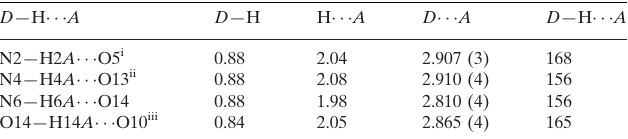
Hydrogen-bond geometry (A˚ , (cid:3)